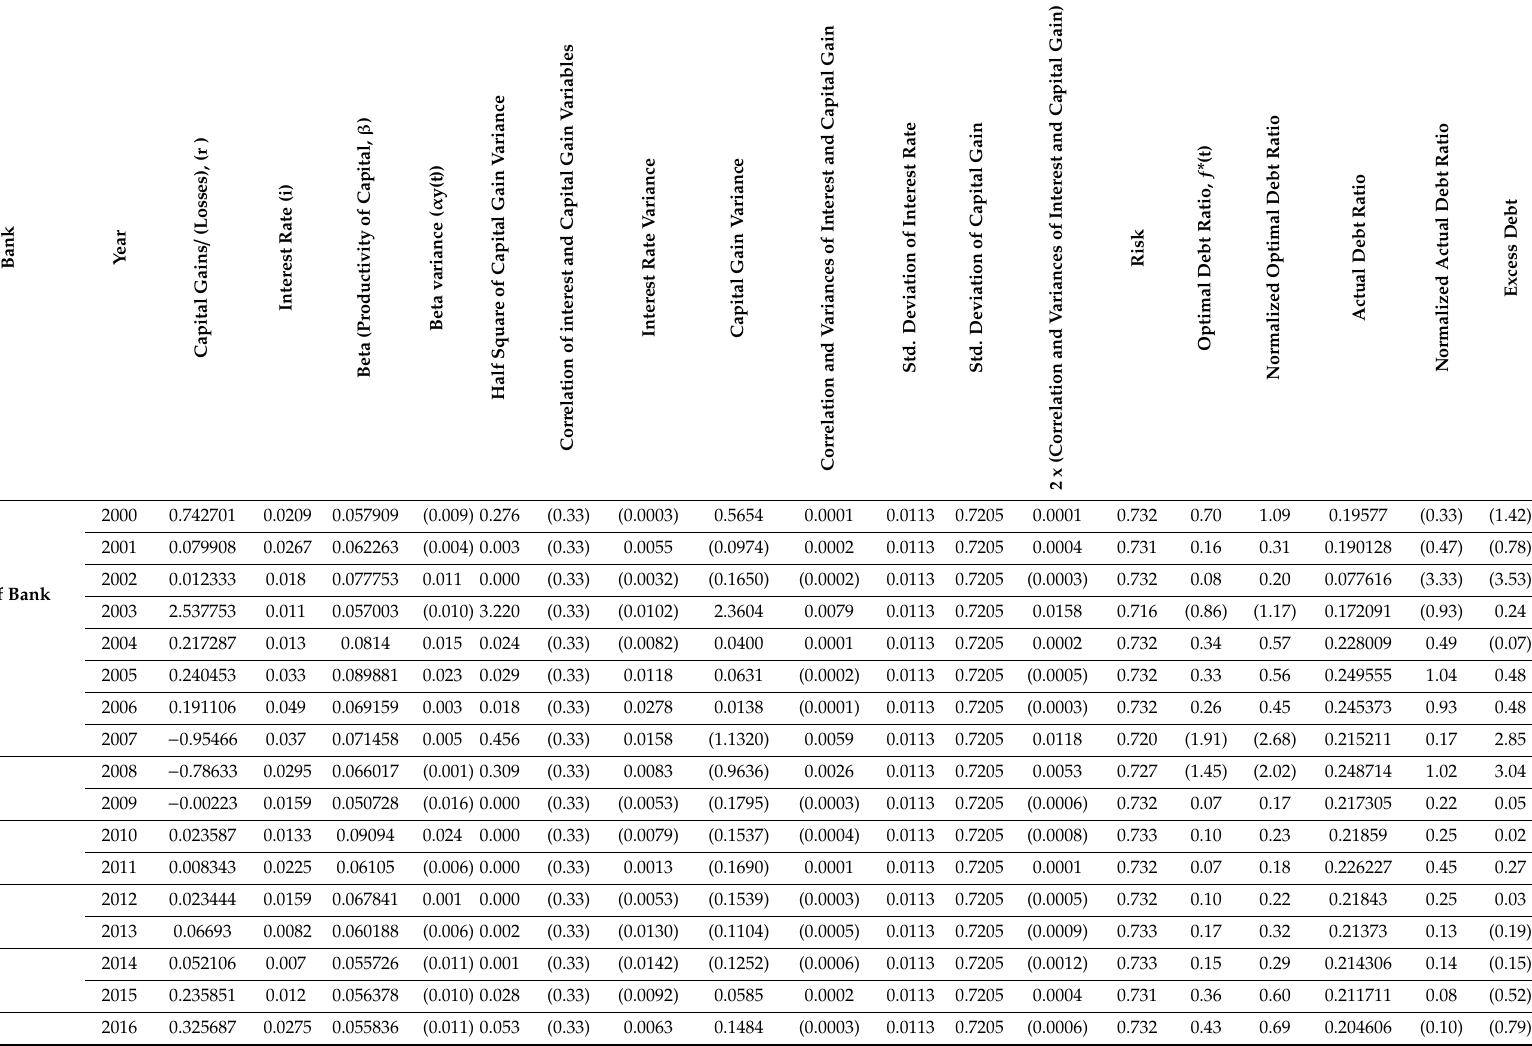
Table A7. Calculations of Optimal and Excess Debt: Gulf